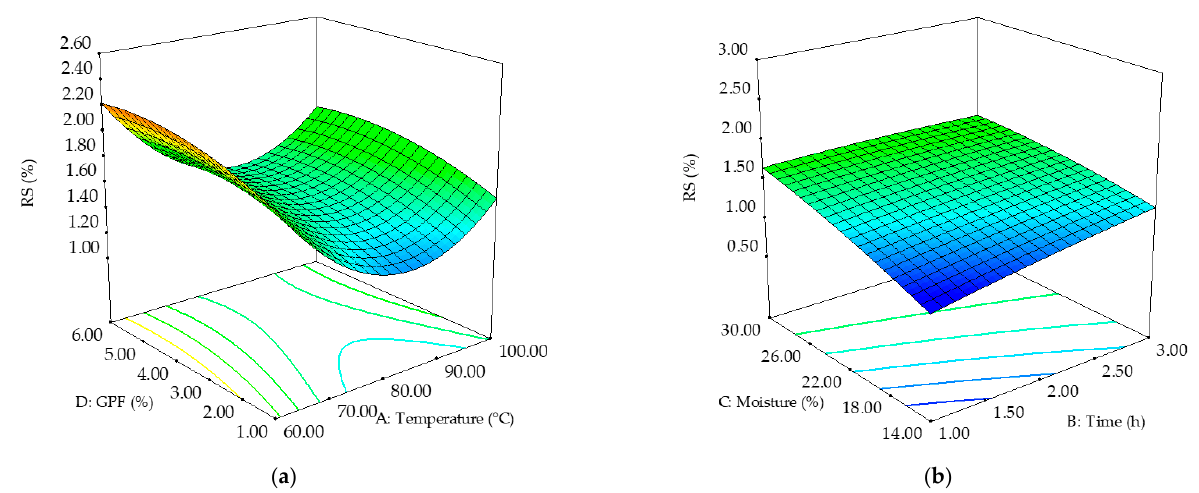
Figure 9. Three-dimensional response surface plots presenting the synergistic effects of factors: GPF level–temperature ( a ) and moisture-time ( b ) on pasta resistant starch (RS).